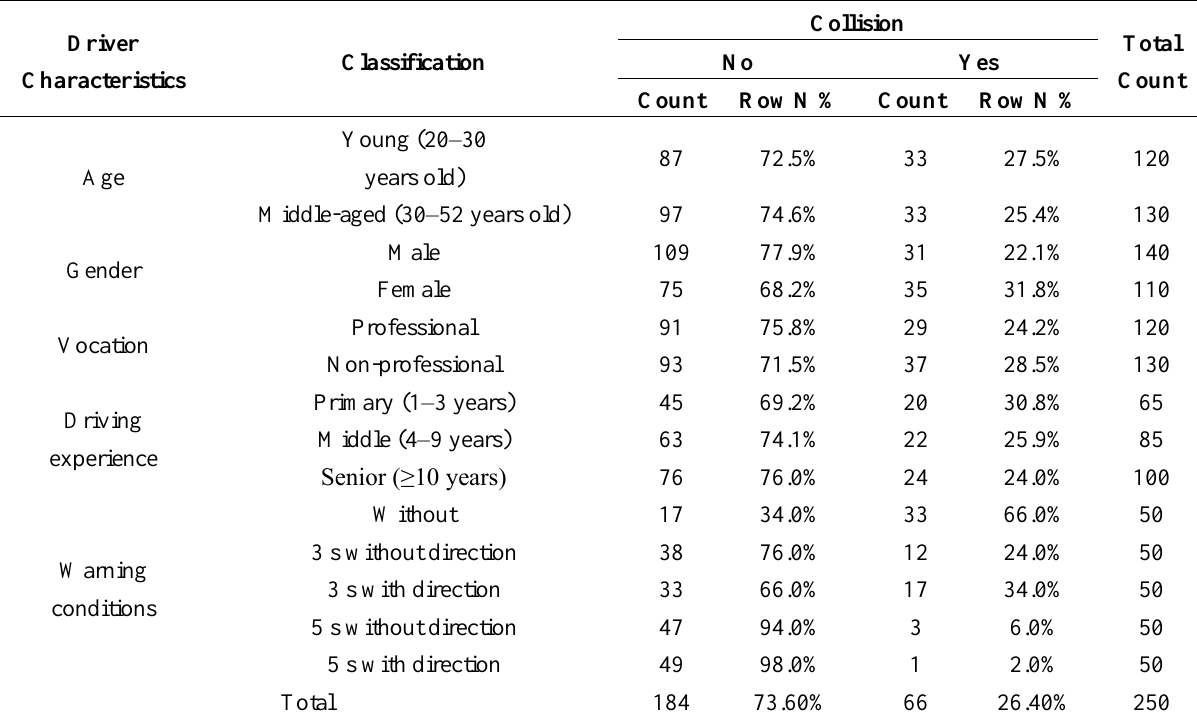
Table 4. Descriptive statistics of collisions in